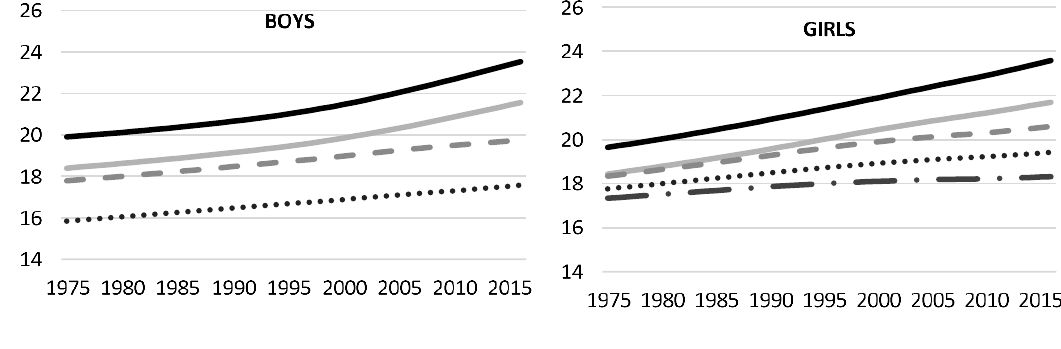
Figure 1. Average BMI by club membership.